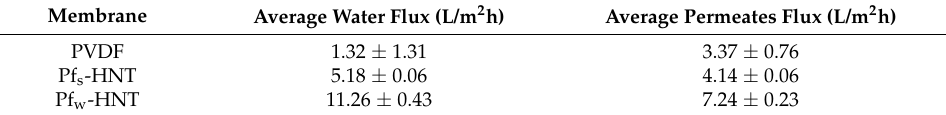
Table 3. Average flux of water and aquaculture seawater permeate.